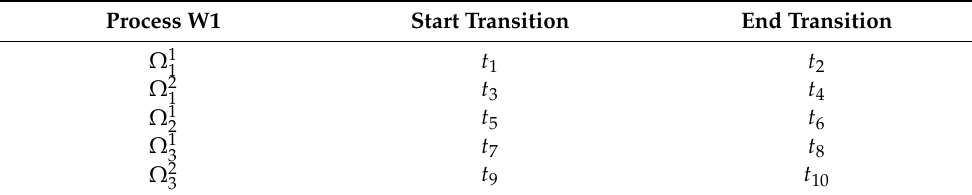
Table 3. Start Transition and End Transition in each process of Example 1.